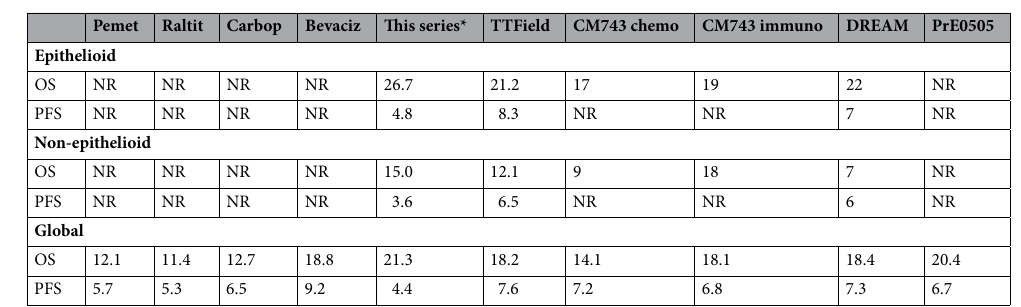
Table 3. Efficacy of treatment by histology in clinical trials. Pemet pemetrexed, Raltit raltitrexed, Carbop carboplatin, Bevaciz bevacizumab, NR not reported. *OS of patients treated with 1st line chemotherapy, PFS in 1st